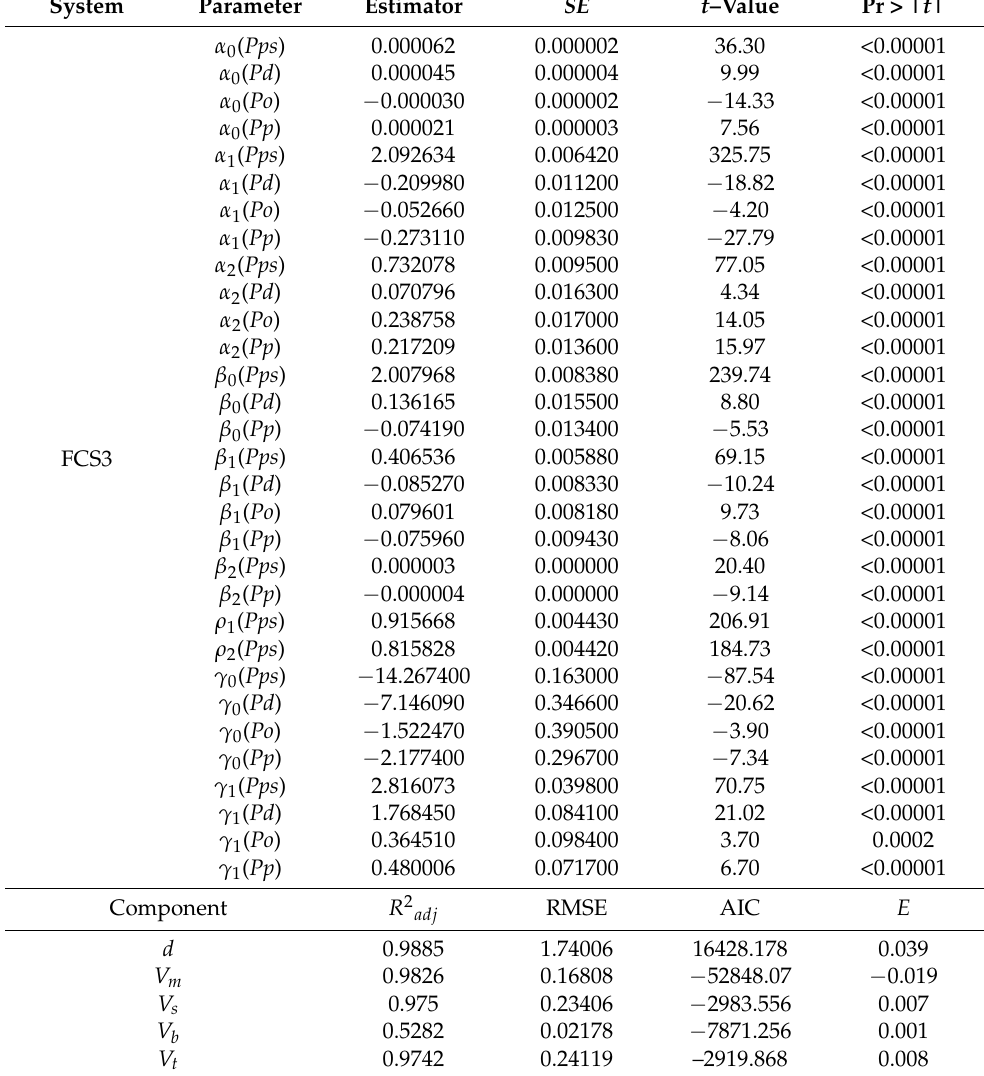
Table 4. Estimated parameters and fit statistics of the simultaneous fitting of full compatible